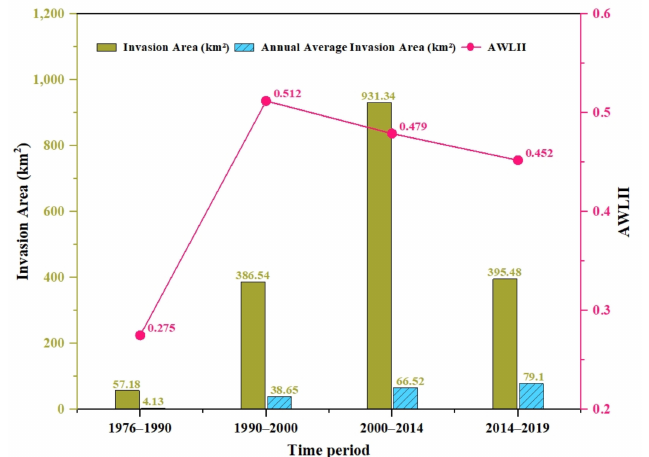
Figure 8. Area of wetlands invaded by built-up land, average annual invasion area, and the corre- sponding AWLII by time